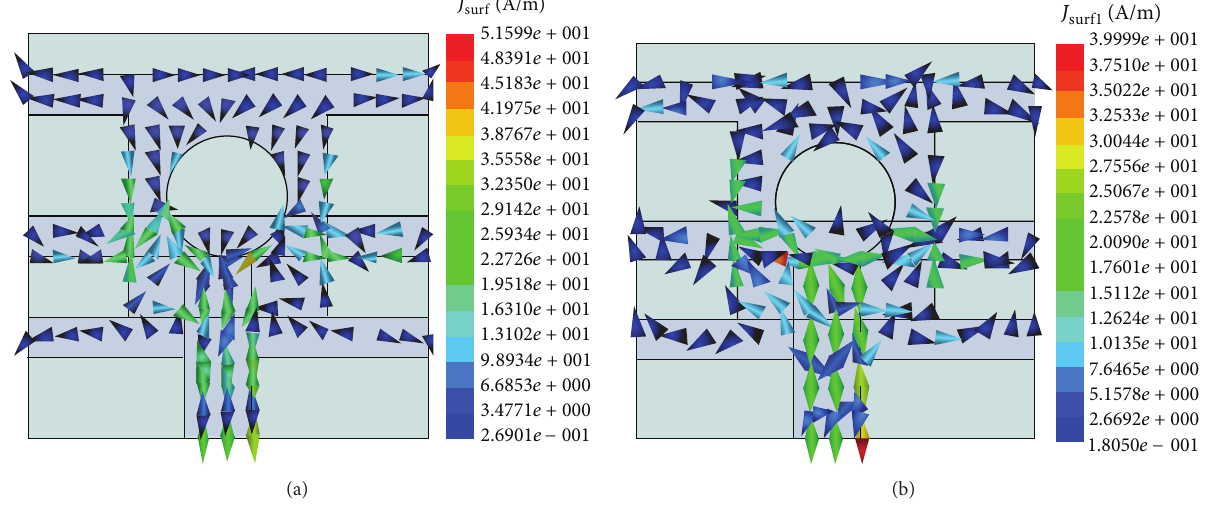
Figure 13: Current distribution at (a) 11.32 GHz and (b) 14.96 GHz.